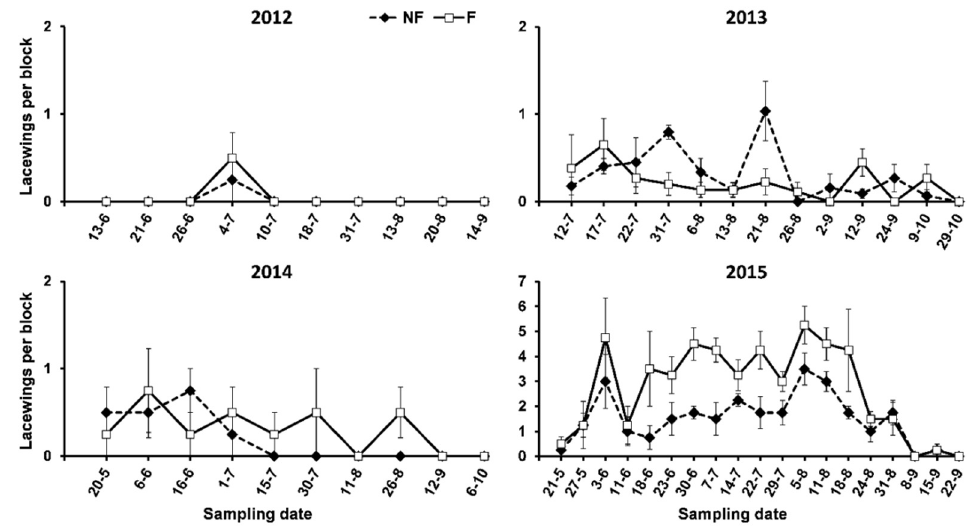
Figure 4. Abundance of lacewings on oleanders in plots surrounded (F) and not surrounded (NF) by service plants in the study period.